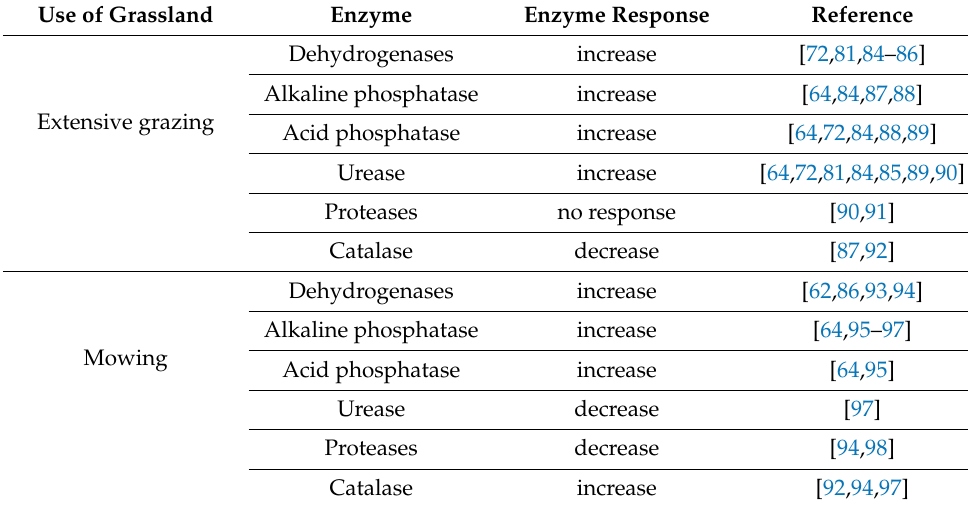
Table 1. Effect of grassland use on enzymatic activity. Use of Grassland Enzyme Enzyme